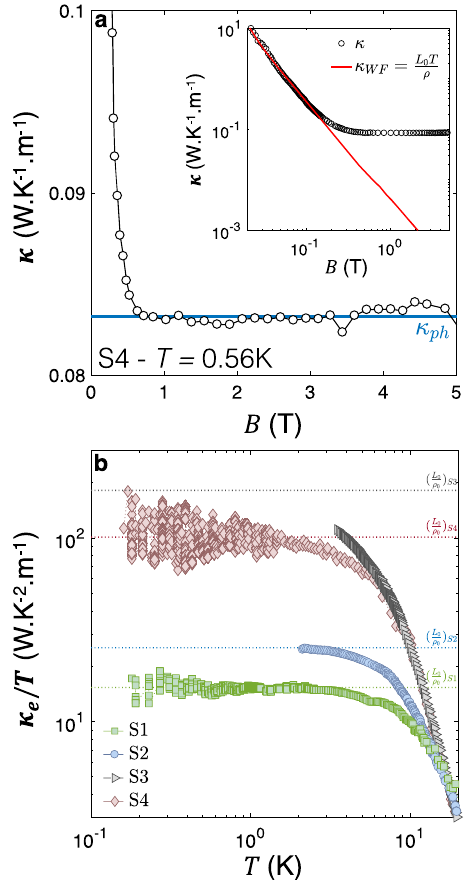
Fig. 4 Using a magnetic fi eld to extract electronic and phononic components of thermal conductivity. a Magnetic fi eld dependence of the thermal conductivity of sample S4 at T = 0.56K. The averaged fi eld- independent fraction of κ , associated with the phonon contribution to κ is shown as κ ph . The inset shows a comparison of κ and κ WF ¼ TL 0 ρ ð B Þ as a function of the magnetic fi eld. For B > 0.5T, the electronic thermal conductivity becomes negligible in regard of the phonon contribution. b Temperature dependence of the electronic thermal conductivity κ e = κ − κ ph plotted as κ e / T . Horizontal lines representing L various samples are featured in the effect of several fi elds presented in Supplementary Fig. 4. Below